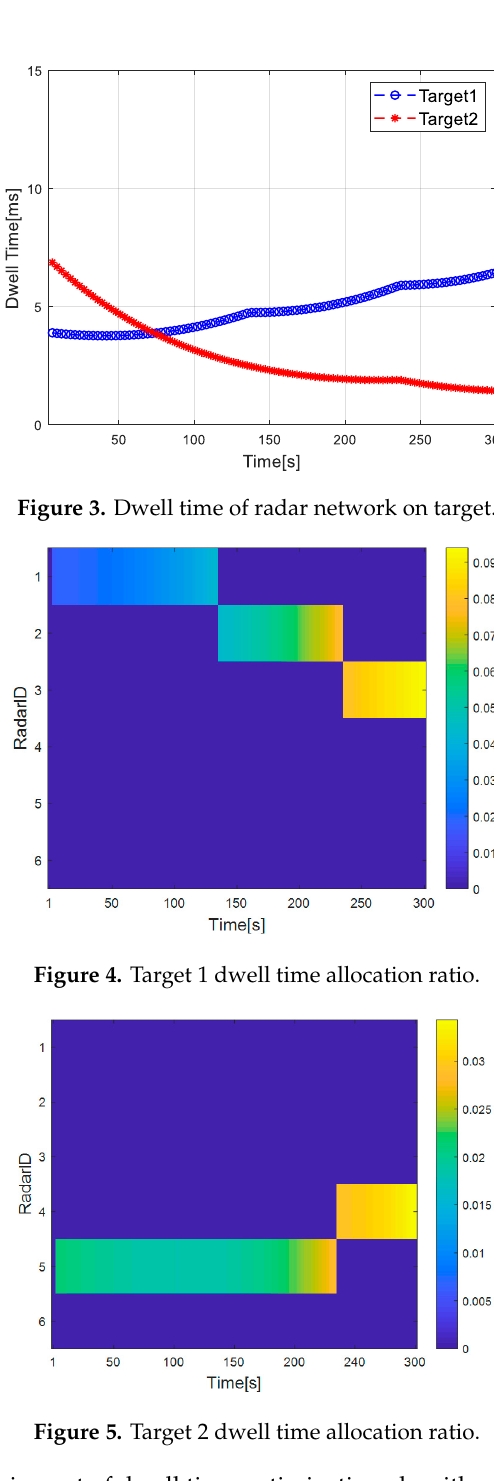
Figure 2. Assignment result between radar and target in radar network.